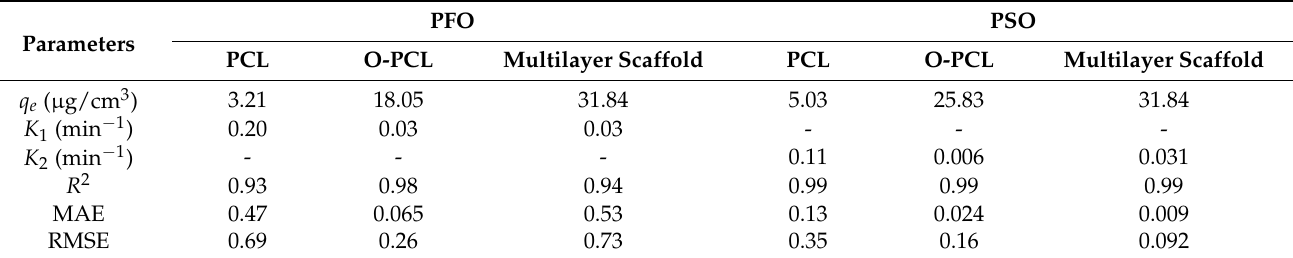
Table 5. Pseudo-first-order (PFO) and pseudo-second-order (PSO) kinetic models parameters for FBS protein adsorption on PCL, O-PCL, and the multilayer scaffold. q e ( µ g/cm 3 ) is the protein adsorbed at equilibrium, R 2 is the correlation coefficient of the goodness of fit, and K L (min − 1 ) and K f (min − 1 ) are the kinetic constants of PFO and